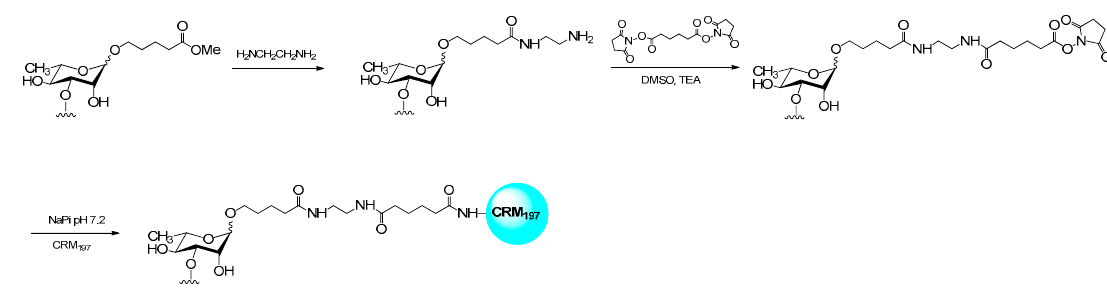
Figure 3. Oligosaccharide conjugation to CRM 197 .